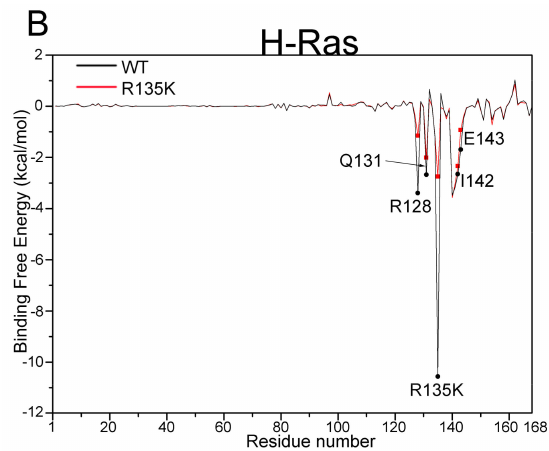
Figure 6. Free energy contributions to the binding of NS1 to H-Ras decomposed into each residue corresponding to the NS1 ( A ) and H-Ras ( B ). The residues whose energy contribution was greater after mutation for more than 0.3 kcal/mol were specified respectively.